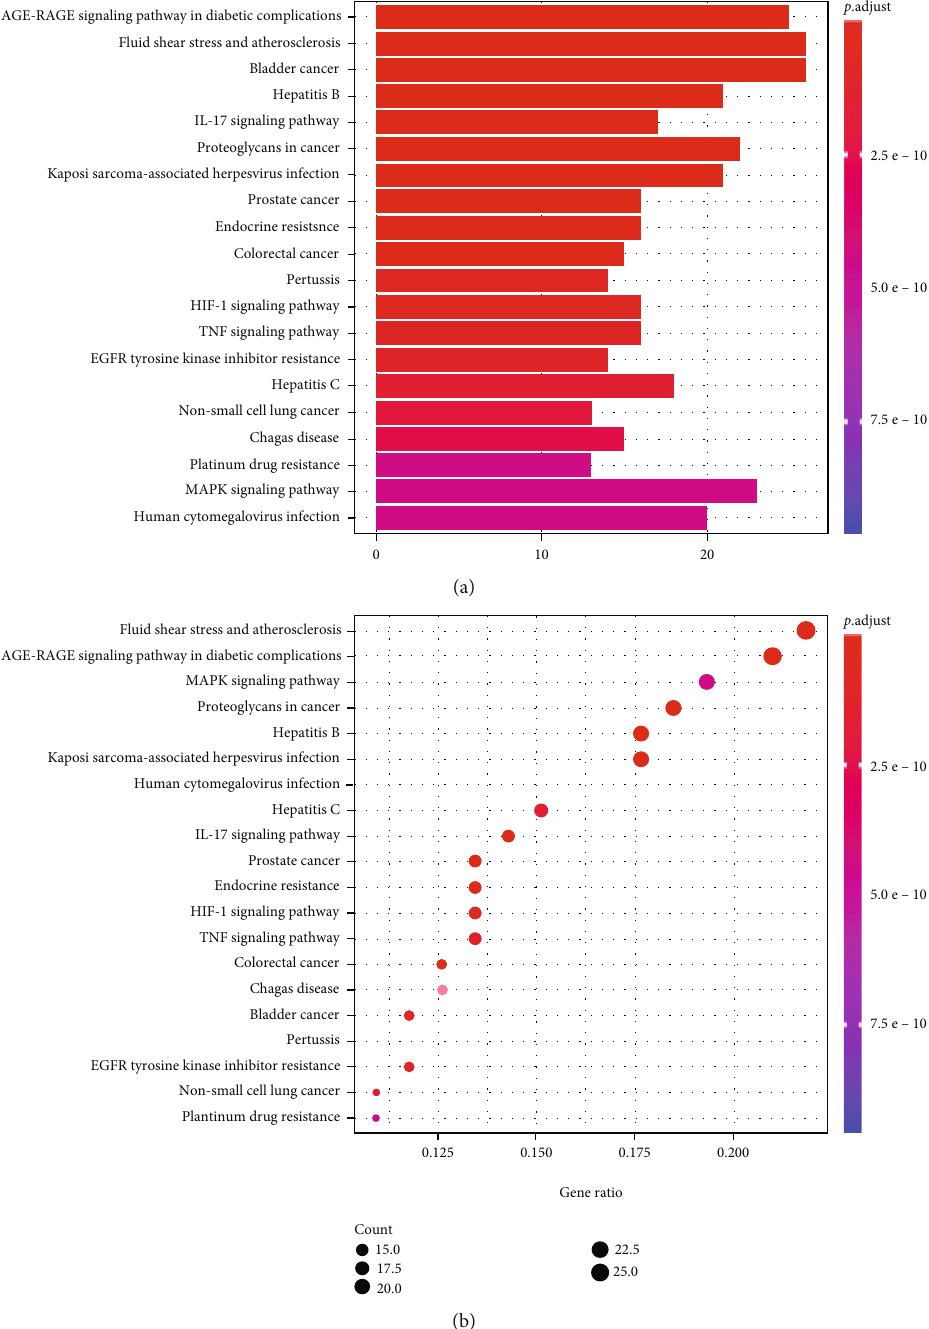
Figure 6: KEGG pathway enrichment analysis. (a) The red color in the upper part represents greater signi fi cance, while the blue represents less signi fi cance according to corrected P value. (b) The bubble diagram demonstrates the gene proportion enriched in each